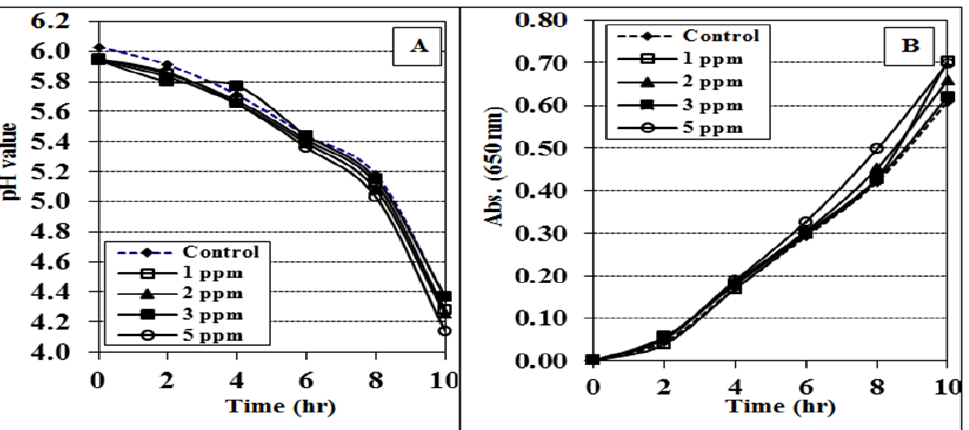
Figure 1. Effect of chromium chloride (CrCl 3 ) on the pH ( A ) and absorbance ( B ) progress of MRS broth media inoculated with yoghurt culture and incubated at 40 °C for 10 h. The data are shown as mean ± SE for three replicates.